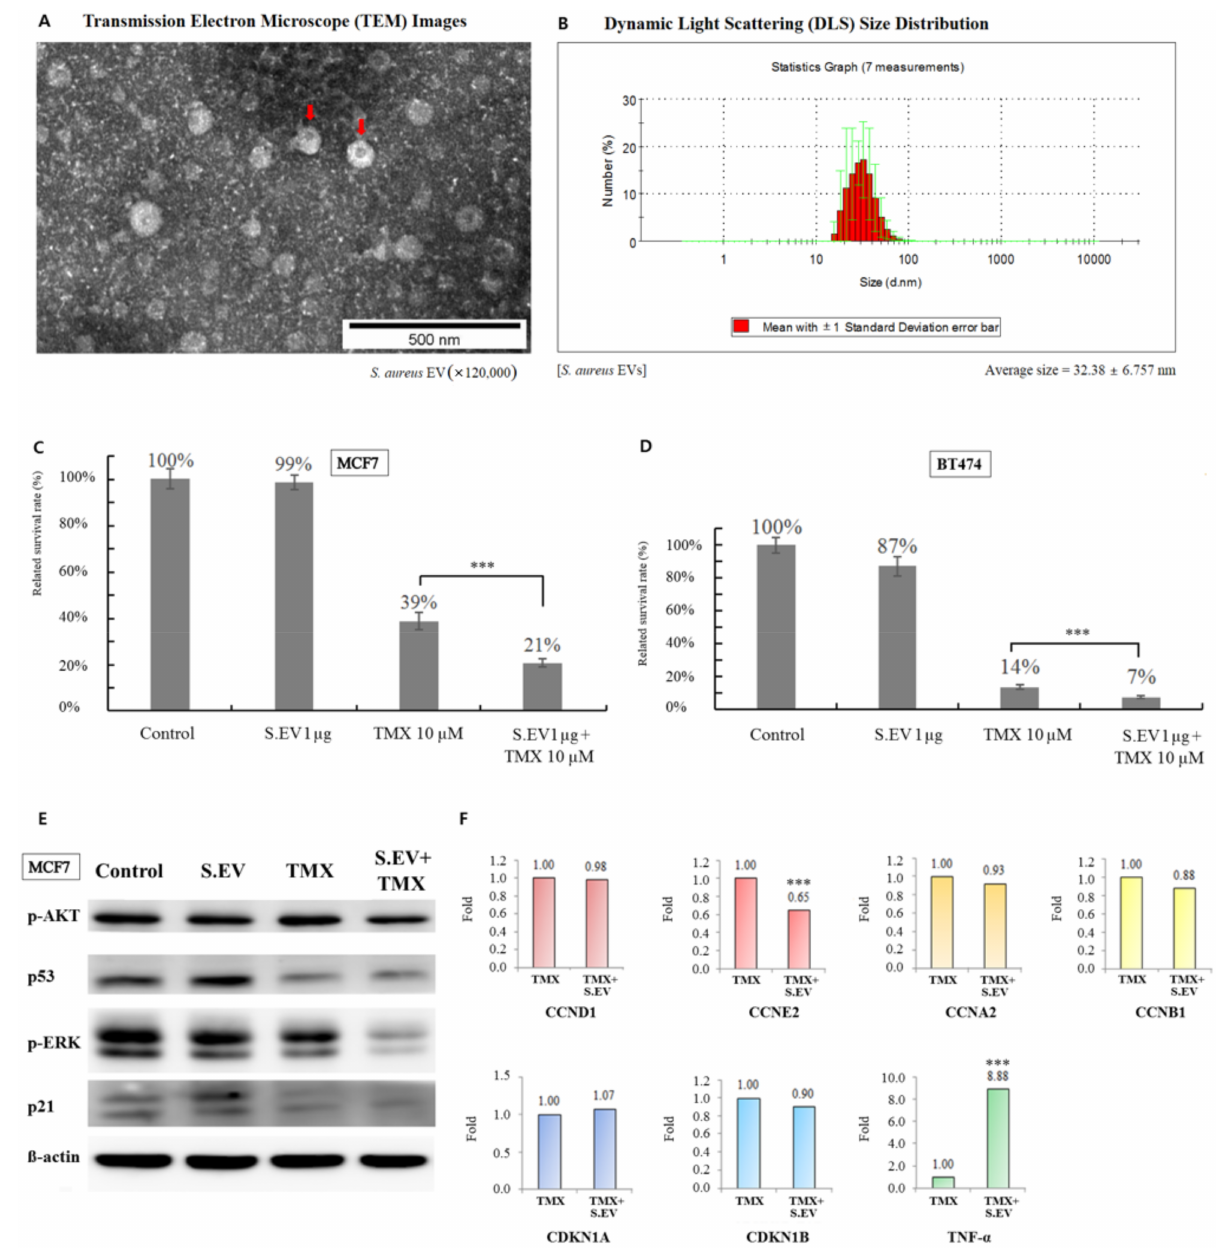
Figure 4. Effect of combination treatment with S. aureus EVs and tamoxifen in breast cancer cells. ( A ) EVs derived from S. aureus (indicated by a red arrow) were confirmed by transmission electron microscopy. ( B ) The average diameter of S. aureus EVs was obtained using dynamic light scattering size distribution. ( C ) The bar chart shows the percentage of viable MCF7 cells after treatment with S. aureus EVs and/or tamoxifen. ( D ) Relative BT474 cell survival percentages after treatment with S. aureus EVs and/or tamoxifen. This experiment was repeated three times. ( E ) Protein expression of p − AKT, p53, p − ERK, and p21 was detected by Western blotting after tamoxifen and/or S. aureus EVs treatment. lane 1, control; lane 2, S. aureus EVs 100 ng/mL; lane 3, 10 µ M tamoxifen; lane 4, 10 µ M tamoxifen plus S. aureus EVs 100 ng/mL. ( F ) The mRNA expression of cyclins, cyclin − dependent kinase inhibitors, and TNF − α was confirmed by qRT − PCR. CCND1, cyclin D1; CCNE2, cyclin E2; CCNA2, cyclin A2; CCNB1, cyclin B1, CDKN1A:p21, and CDKN1B:p27; TNF − α , tumor necrosis factor − α . *** p <